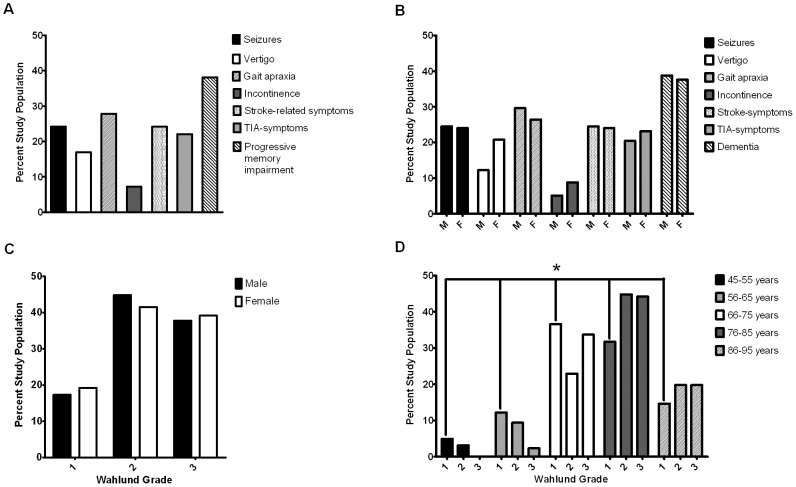
Neurological symptoms at admittance.The symptoms at admittance are described as (A) total prevalence in study population (n = 223) and (B) their relative frequency according to gender (M  =  male, F  =  female). The symptoms could co-occur in patients and are therefore not mutually exclusive. After correcting for the greater number of female subjects included, all symptoms were equally distributed across genders. (C) Equivalent distribution of white matter lesion severity across genders. (D) Age influences the severity-grading of WML/lacunar infarcts. Mean age of patients was 77.32±9.09 years. The highest prevalence of WML/lacunar infarcts was found in patients 75–85 years of age, representing 42% of the entire study population. There was an age effect on lesion severity (described by Wahlund, et al., 2001) of CM (One-way, ANOVA, *p = .012).